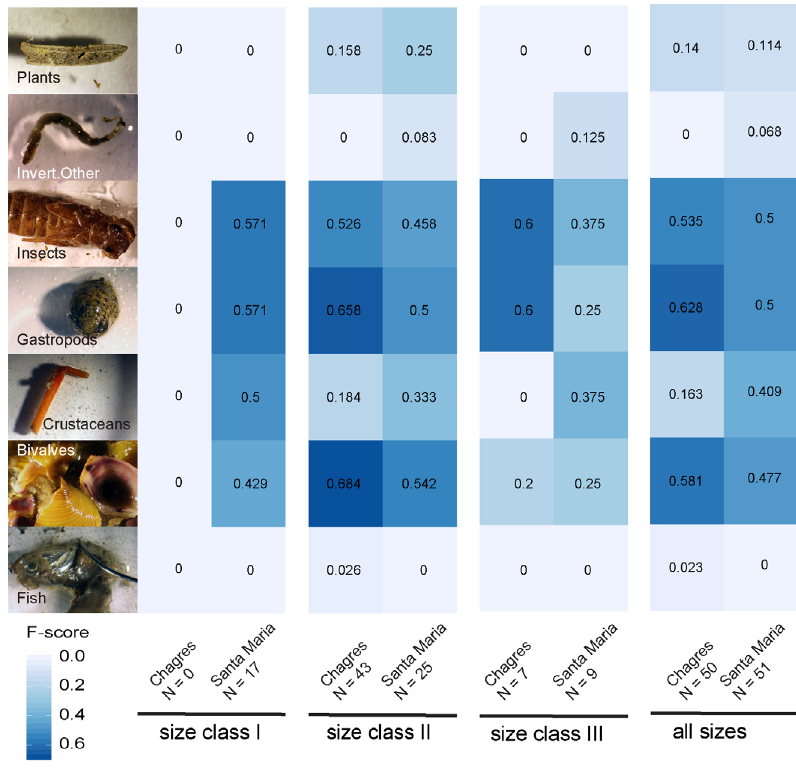
FIGURE 5 | Comparison of frequency occurrence (F-score) for seven prey categories in stomach contents of Cathorops tuyra broken down by size class for Chagres River (freshwater) and Santa Maria River (brackish) populations. Color intensity in the heat map represents frequency of occurrence with darker areas implying higher frequency of a given prey item recorded and vice versa. N: sample